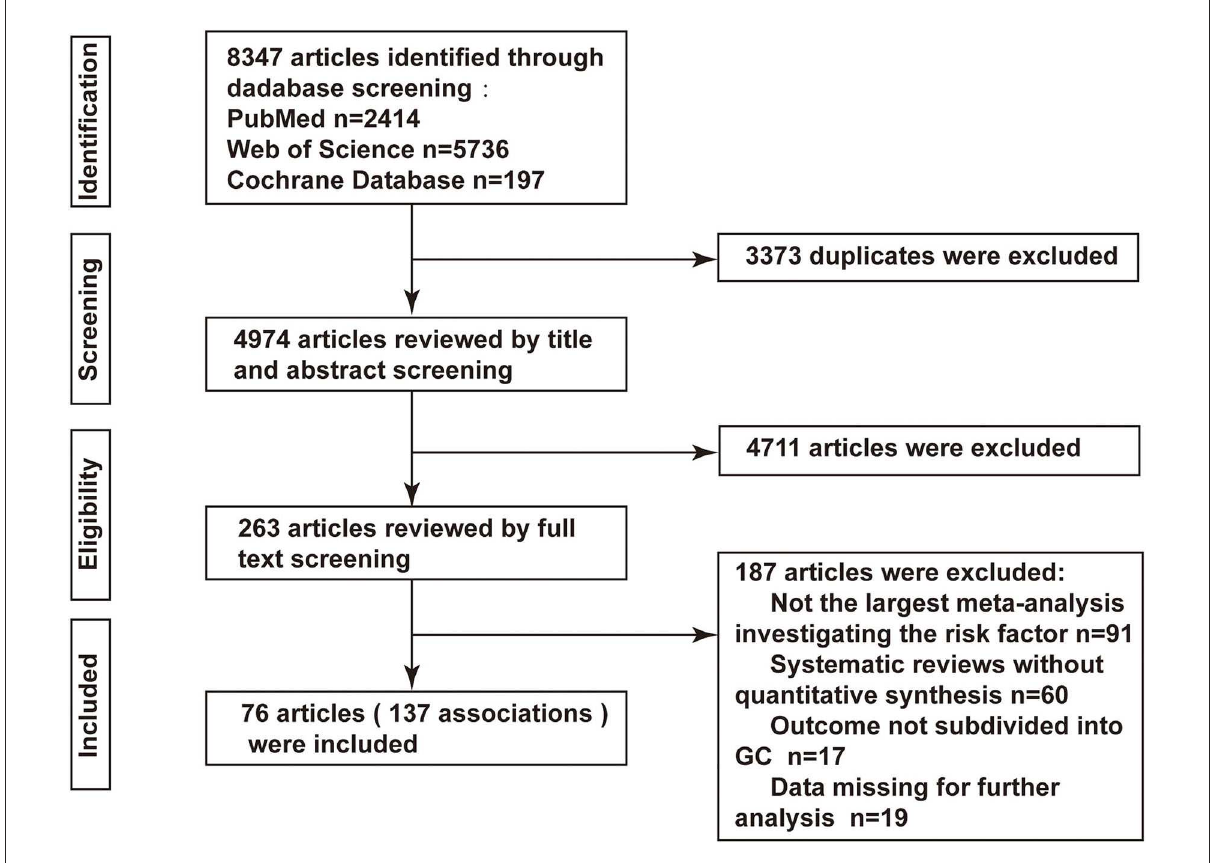
FIGURE1 Flow diagram for literature search and selection process.